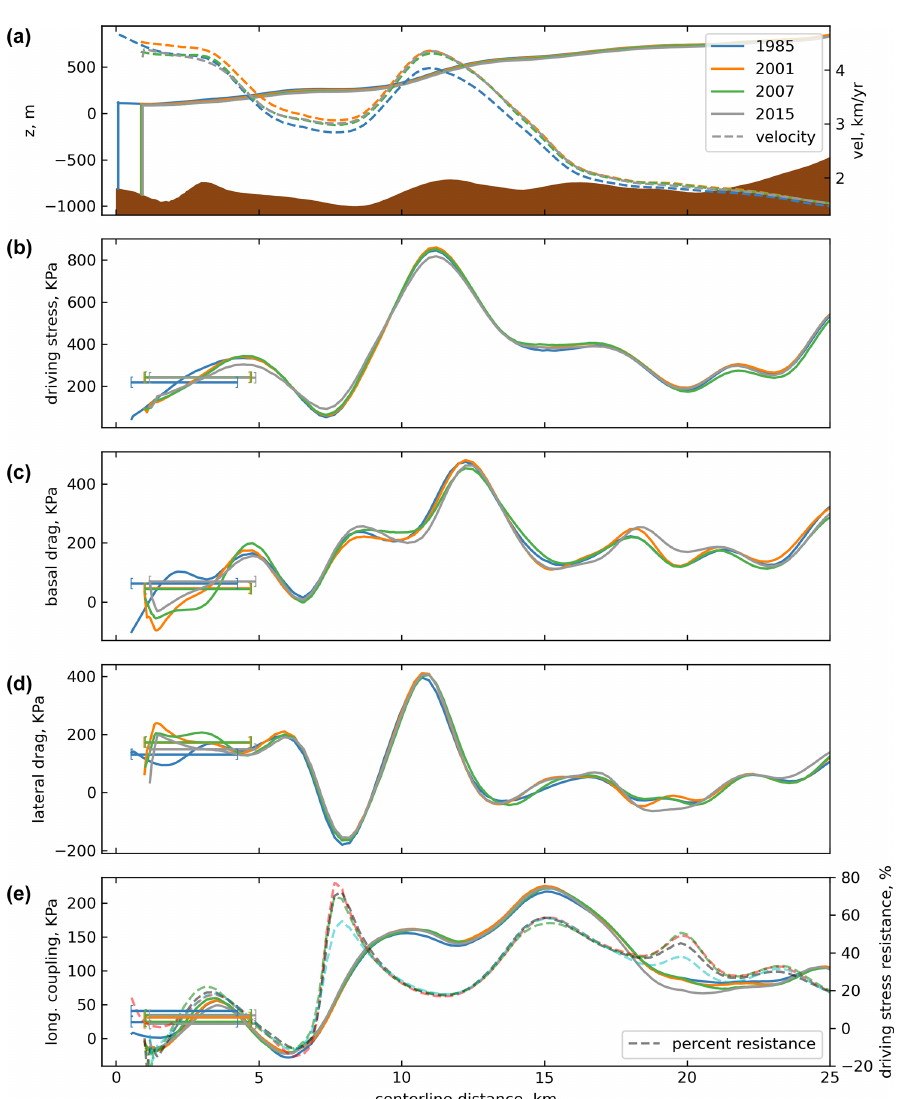
Figure 4. Time series of centerline dynamic components for Rink Isbræ. Marked by the bracketed lines are the average values within one stress coupling length of the terminus at that time. (a) Surface and bed elevation profiles and along-flow velocity. Along-flow (b) driving stress, (c) basal drag, (d) lateral drag, and (e) longitudinal coupling and percentage of driving stress supported by longitudinal coupling. Positive values of driving stress act in the direction of flow; positive values of all other stresses oppose